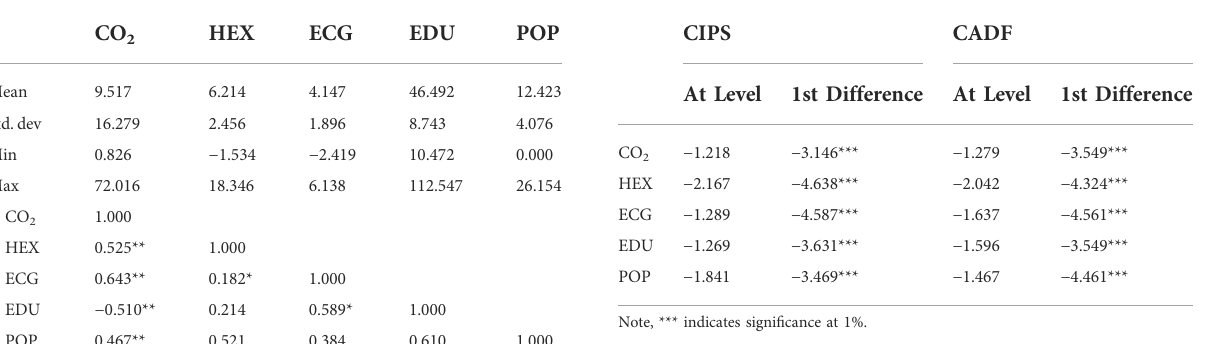
TABLE 1 The Descriptive statistics and Correlation.